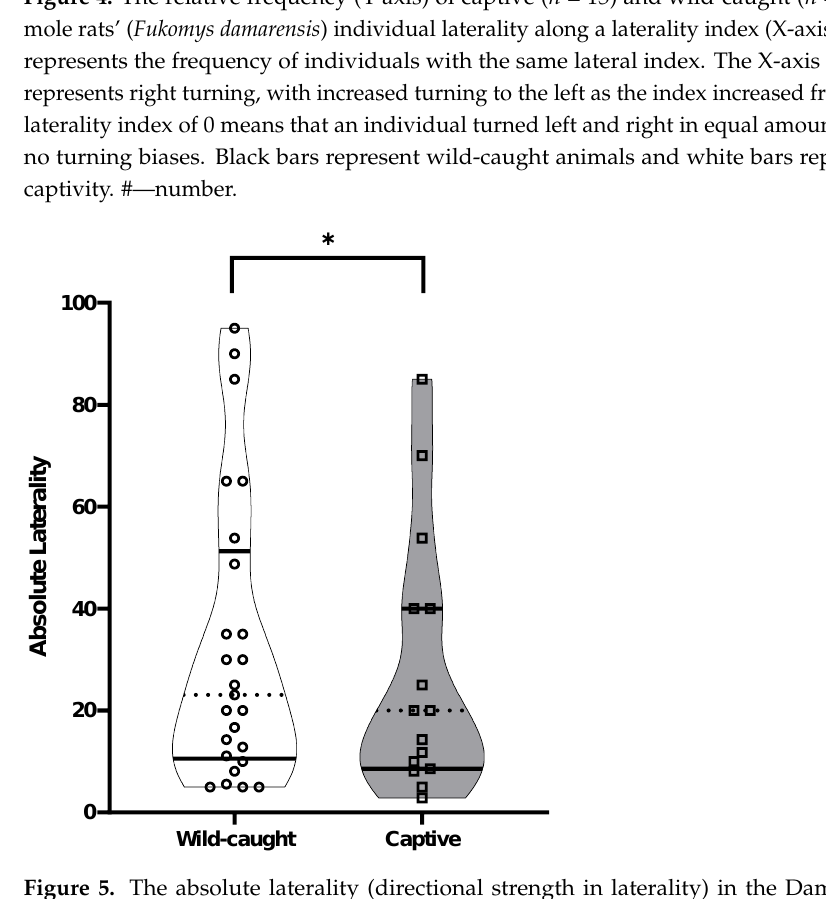
Figure 5. The absolute laterality (directional strength in laterality) in the Damaraland mole rat Fukomys damarensis between wild-caught (open circles: n = 25) and captive animals (open squares: n = 15). The dashed line represents the median, with solid lines representing the upper and lower quartiles. * indicates significance at p < 0.05.